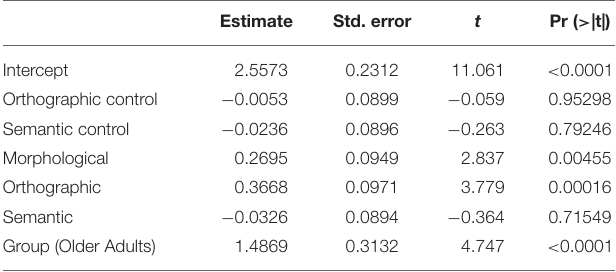
TABLE 1 | Glmer model for response accuracy: fixed effects for the factors G ROUP and P RIME T YPE .